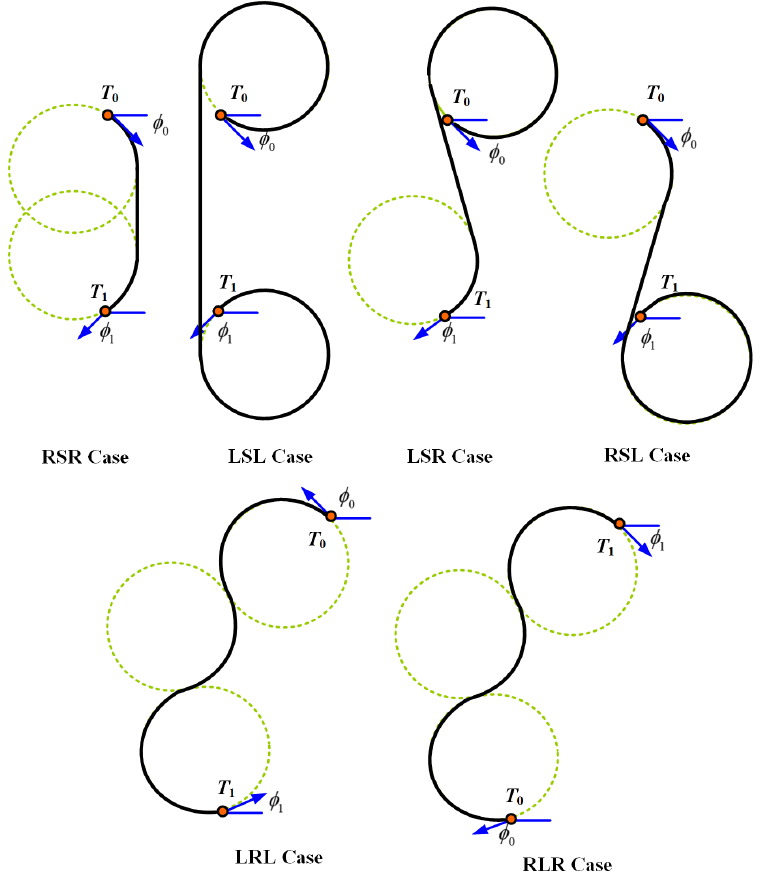
Figure 5. Six cases of the Dubins